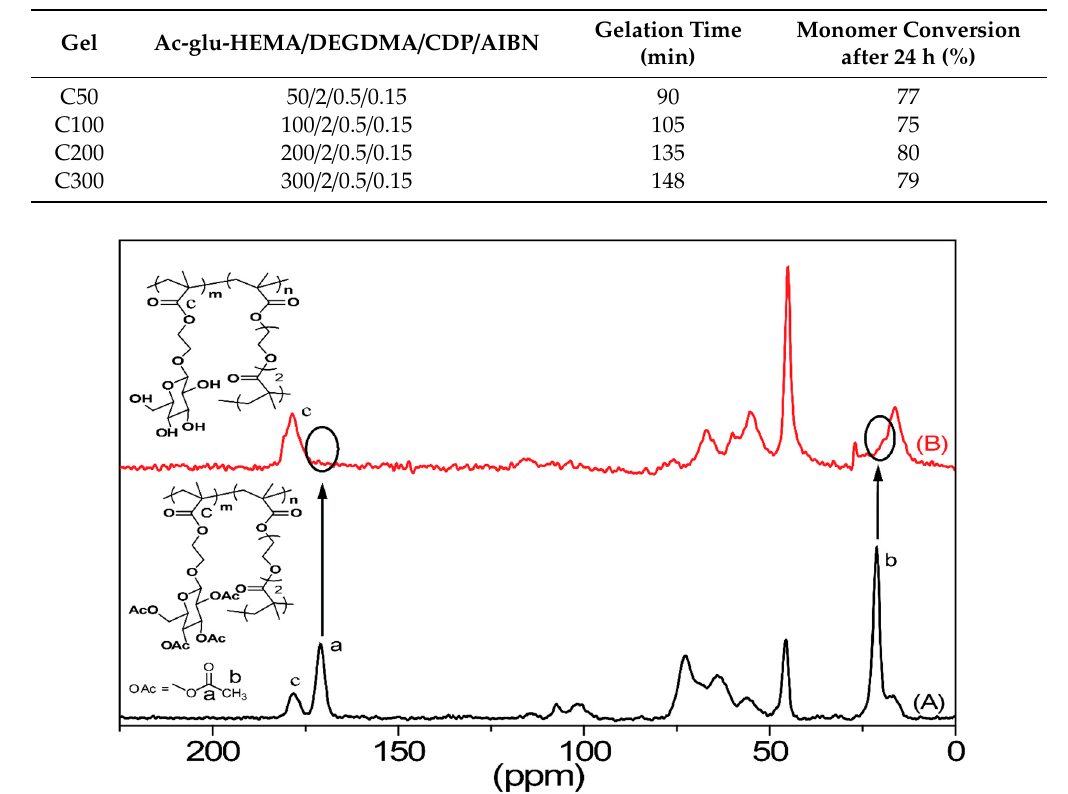
Table 1. Conditions used for RAFT synthesis of organogels.